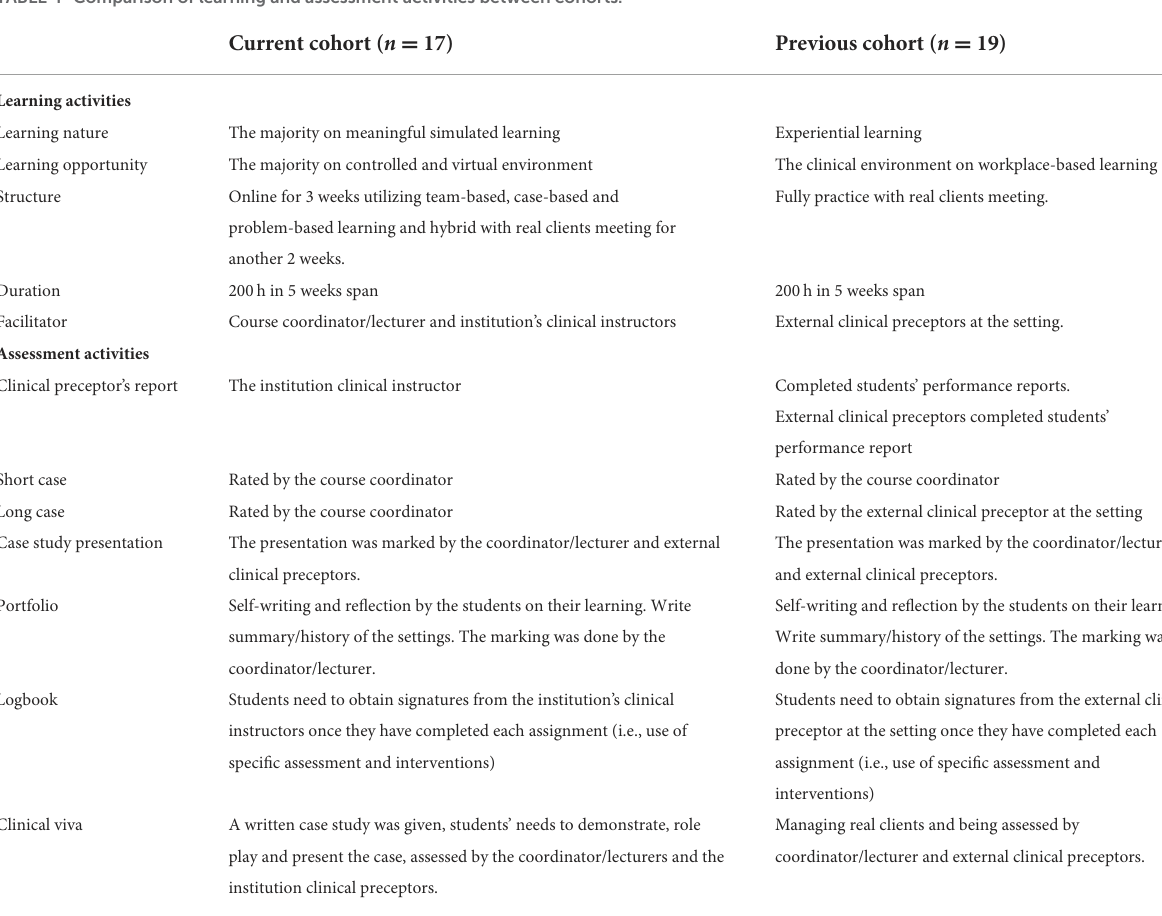
TABLE 4 Comparison of learning and assessment activities between